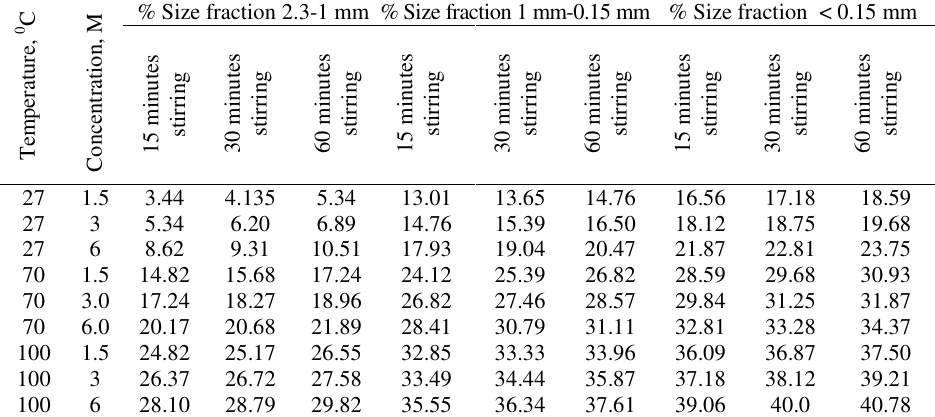
Table 3. Effect of sulfuric acid on leaching of ash